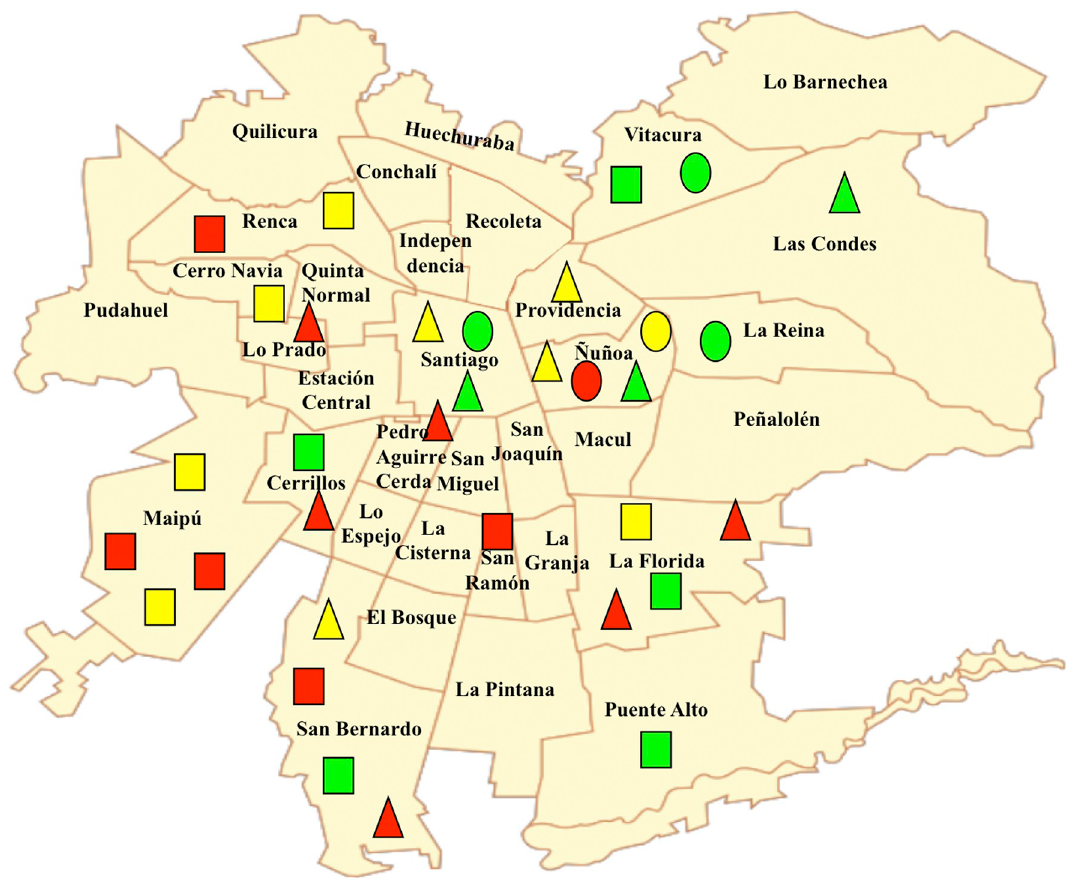
Fig 1. Geographical distribution in the Metropolitan Region of Chile, of the educational establishments chosen in the sample with high (green), medium (yellow) and low (red) level of scholastic achievement in the 2009 SIMCE tests by type of school: Public (triangle); private subsidized (square); private non-subsidized (circle). n = 33.